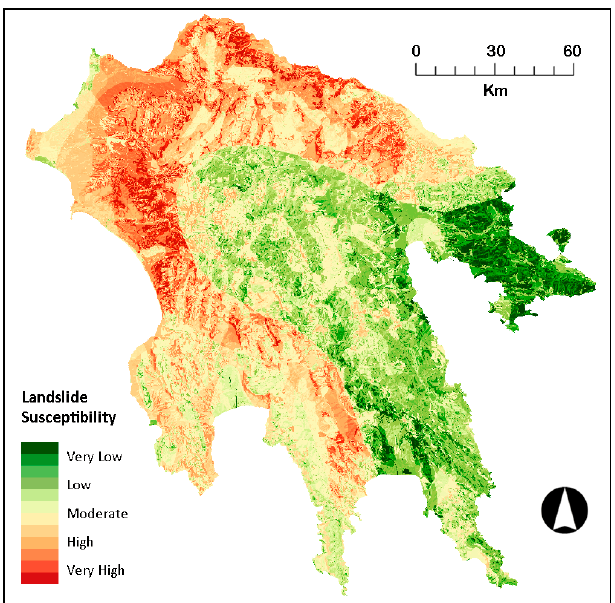
Figure 2. The landslide susceptibility map produced from the integration LSI/TFNW model.